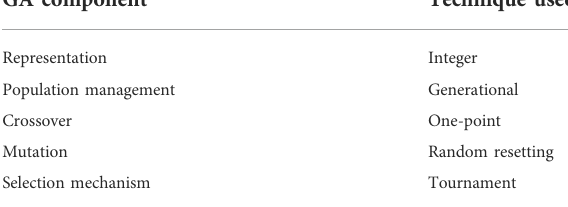
TABLE 1 Characteristics of the proposed genetic